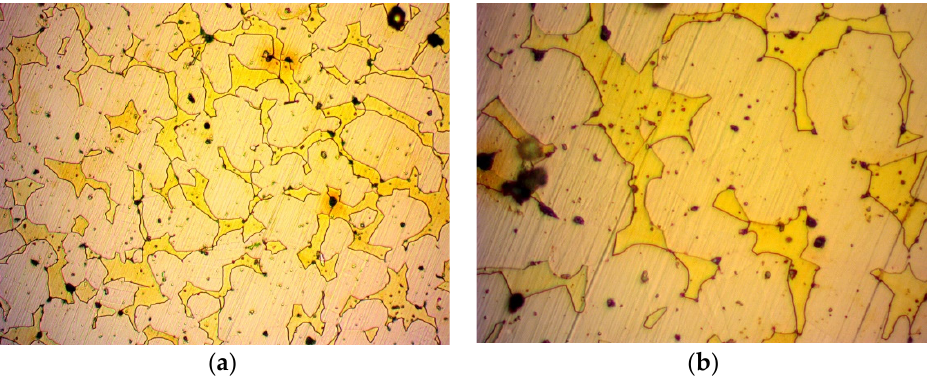
Figure 3. Specimen 1: Image from optical microscope after metallography of non-treated alloy brass: ( a ) magnification ×500; ( b ) magnification ×1000.